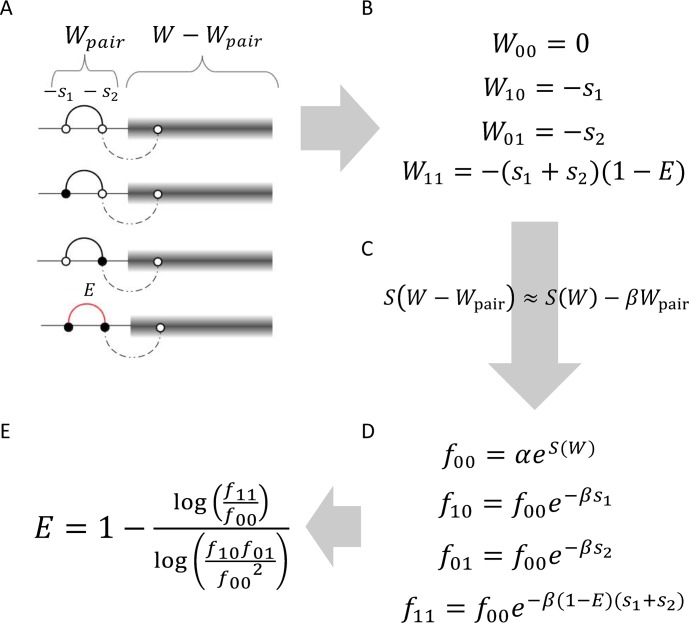
A pair of interacting sites in a long genome.(left) Open and filled circles: wild type 0 and mutated allele 1. Red line: existing interaction. Black line: potential interactions between sites. Dashed line: negligible interaction. Grey box: the rest of genome. (B-E) Derivation of the universal footprint of epistasis explained in the text. W is total fitness, S(W-Wpair) is entropy of the rest of genome, and fii are the haplotype frequencies. Parameter E represents the relative strength of epistasis (Eq 1).